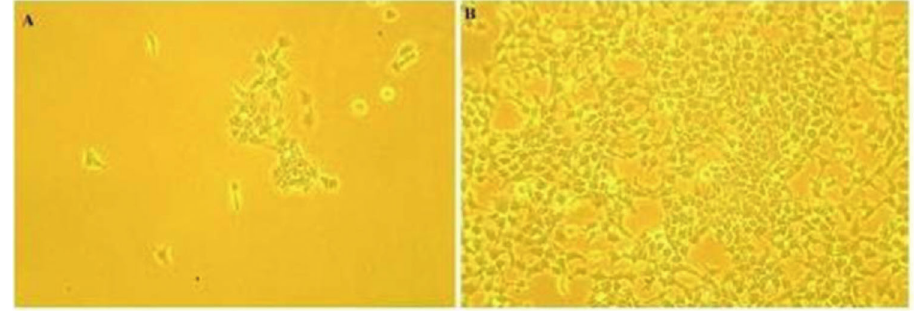
Figure 1 - HEK Cell Culture. A: HEK cell cultures showing the start of culture with a low cell density. B: Cells after seven days of culture showing 85%